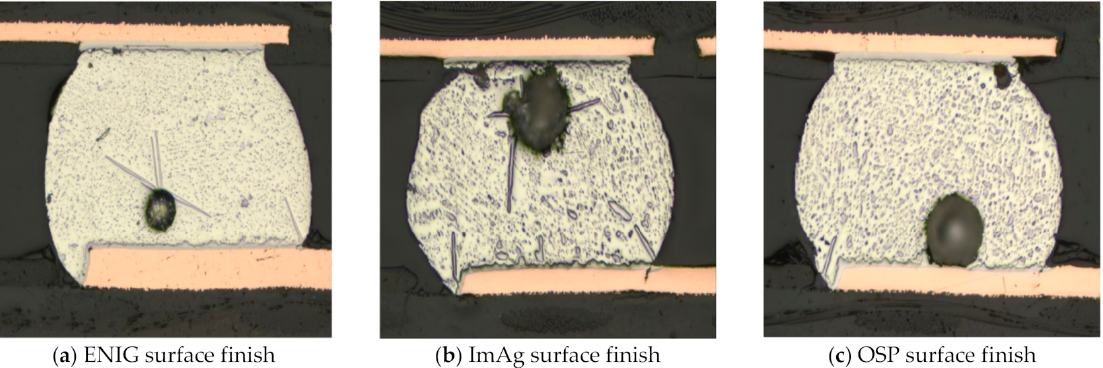
Figure 15. Comparison of SAC-Bi solder joints with different surface finishes with ( a ) ENIG; ( b ) ImAg; and ( c ) OSP.